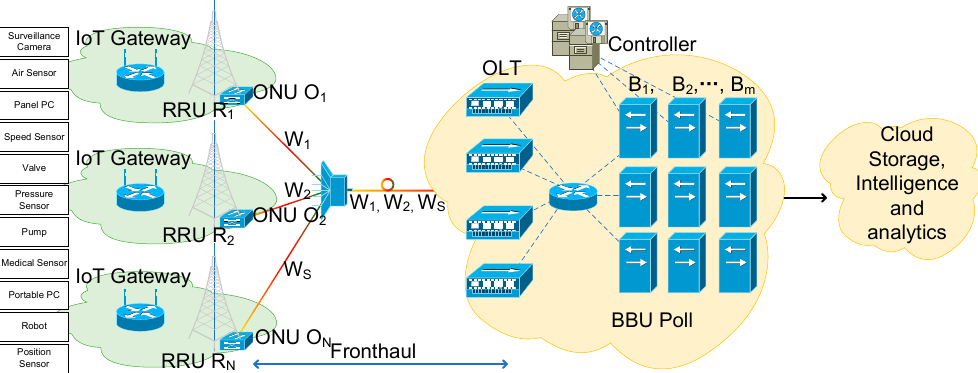
Figure 1. Architecture of IoT network in 5G NSA.